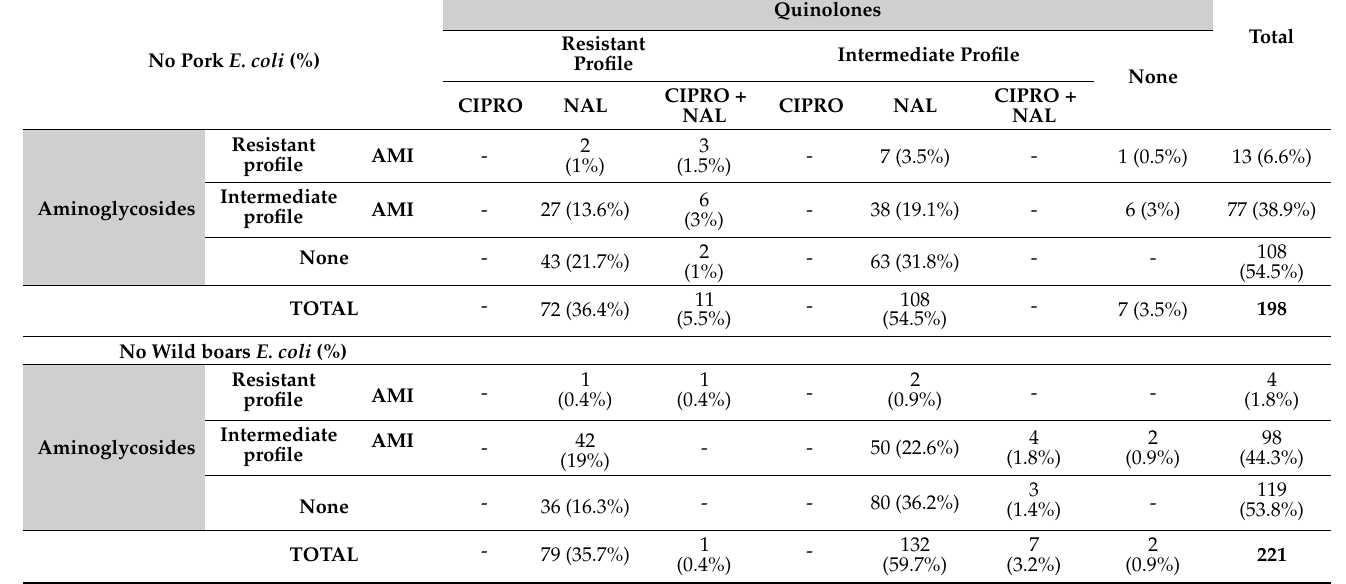
Table 2. Phenotypic resistant and intermediate profiles of E. coli isolated from pork and wild boars meat sample.